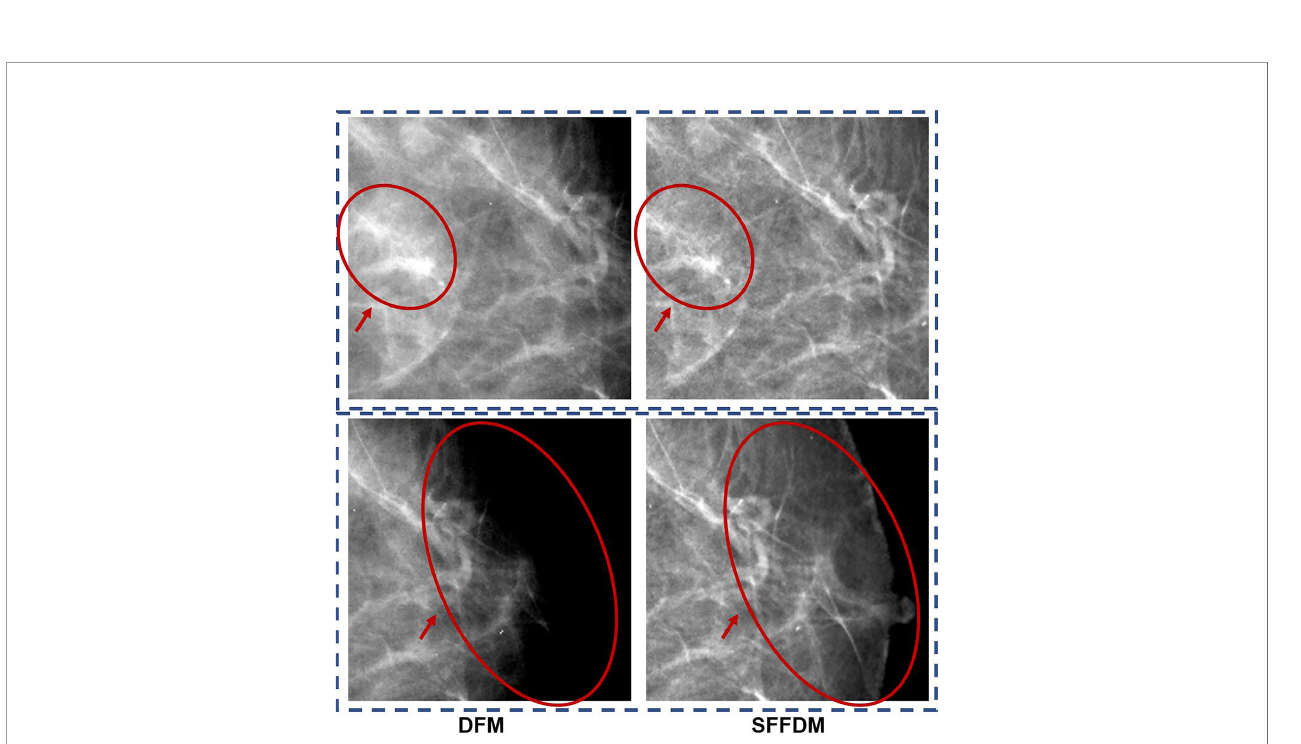
FIGURE 5 | A more detailed visual comparison between DFM and SFFDM. The DFM patch in the fi rst row of the fi rst column showed apparent density while the SFFDM patch in the fi rst row of the second column showed that density is due to overlapping tissue. Additionally, the nipple was barely seen in the DFM patch in the second row of the fi rst column while it was recovered in the SFFDM patch in the DFM patch in the second row of the second